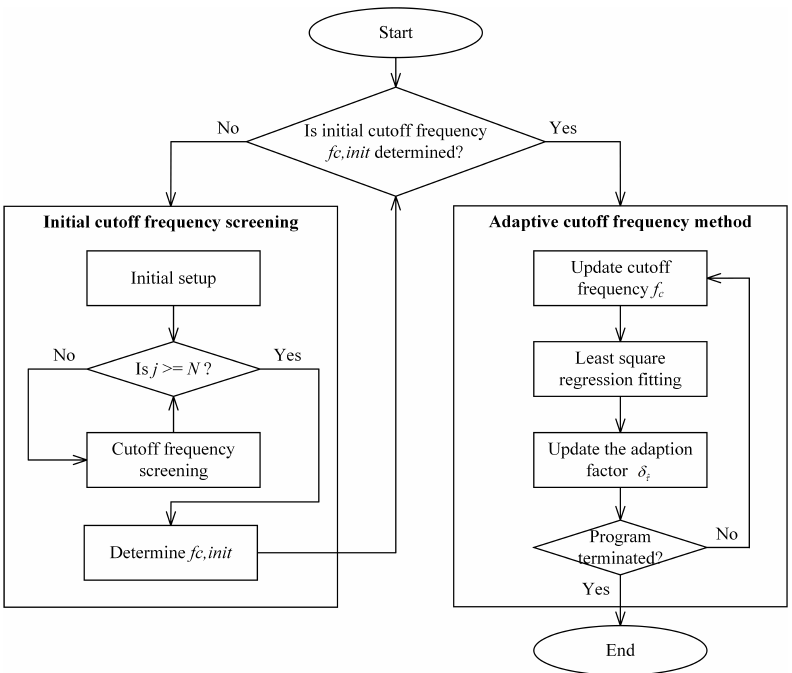
Figure 2. Block diagram of the proposed adaptive cutoff frequency design for Butterworth low-pass filter. Table 1. Step-by-step procedure of the proposed adaptive cutoff frequency design algorithm for the Butterworth low-pass